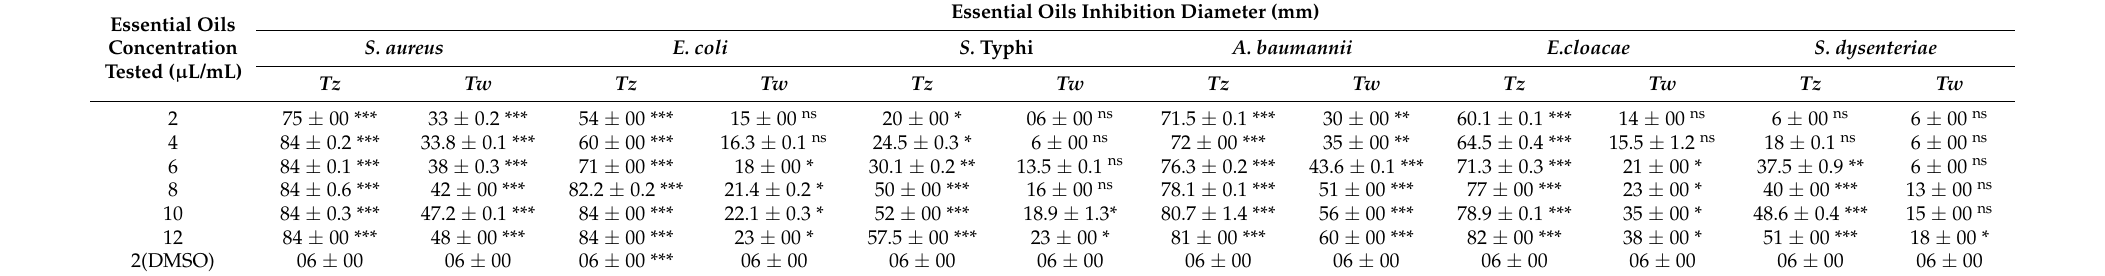
Table 6. Antibacterial activity of T. zygis and T. willdenowii